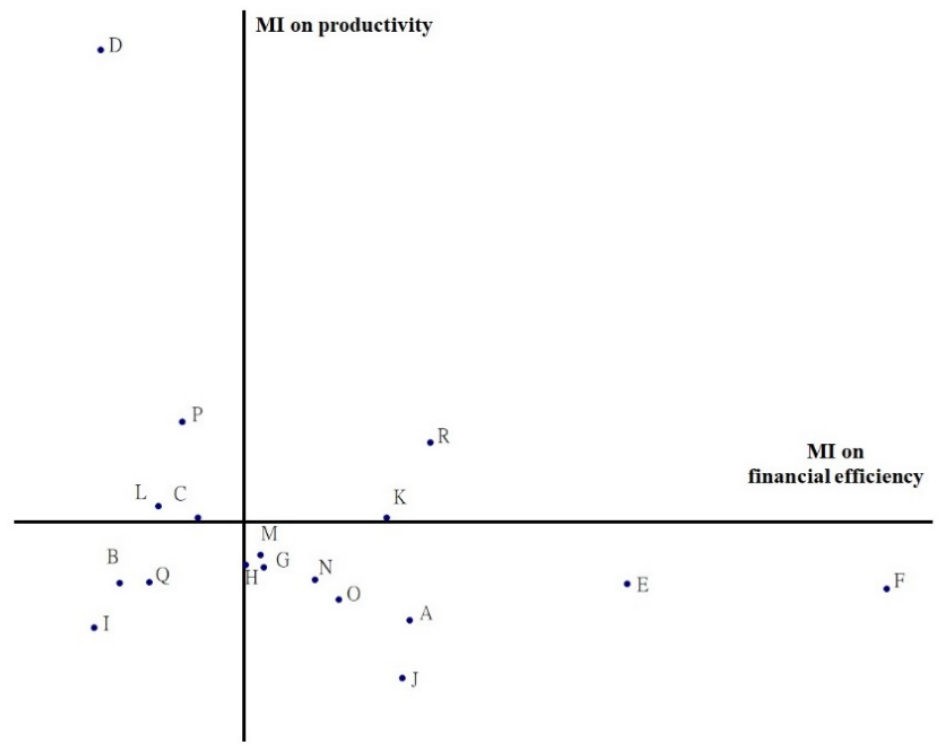
Figure 4. Plot of the Malmquist index (MI) for productivity and financial efficiency.